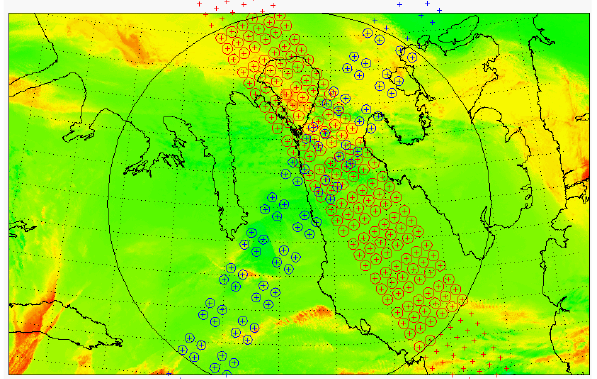
Figure 3. An example of a SNO event of SNPP and MetOp-A at 18:22:22UTC on 27 August 2013. The blue circles indicate the IASI FOVs and the red ones denote CrIS FOVs at nadir view, while the big black circle indicates the searchable range for CrIS and IASI SNO measurements. The VIIRS image at M16 band is superim- posed as the background, where BTs range from 190 (black) to 290K (red). CrIS and IASI orbits crossed each other near the re- gion of north Canada.